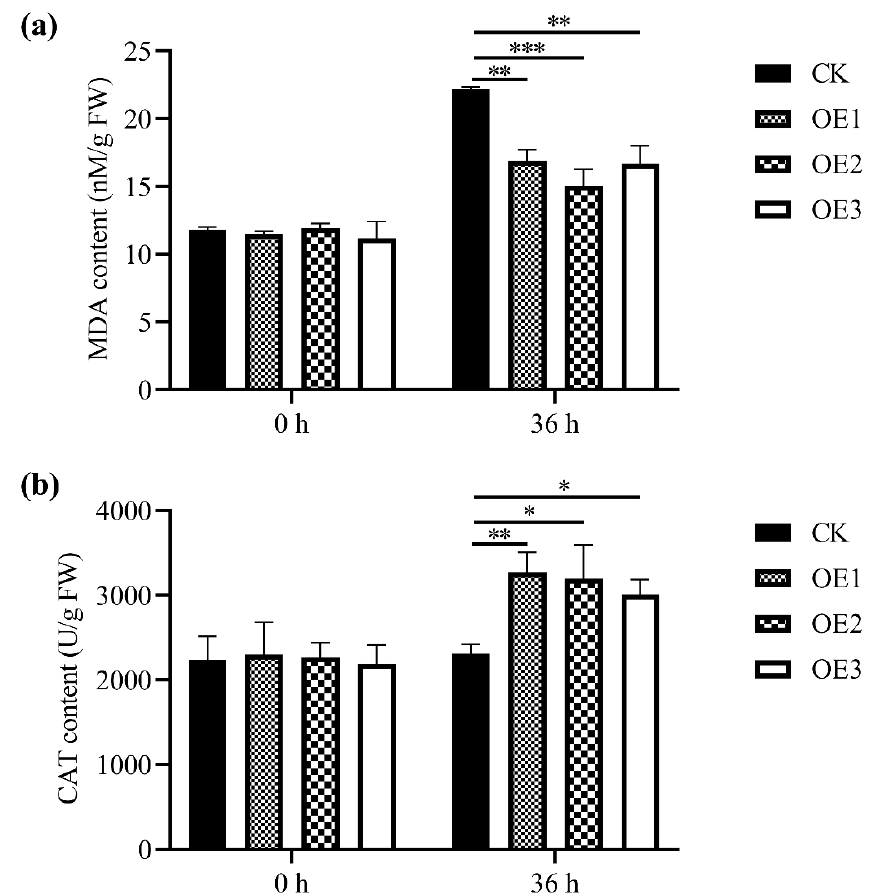
Figure 6. Detection of physicochemical indexes before and after inoculation of B. cinerea . ( a ) Malondialdehyde (MDA) content. ( b ) Catalase (CAT) activity. CK, empty vector transgenic; OE, MnASI1 transgenic. Error bars represent standard deviation, n = 3 (* p -value < 0.05, ** p -value < 0.01, and *** p -value < 0.001; two-tailed t -test).